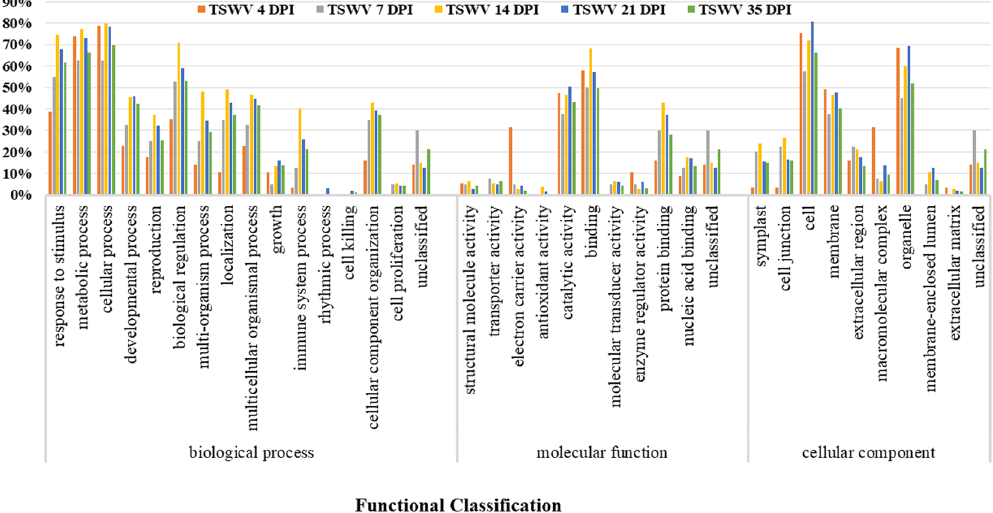
Figure 2. Gene Ontology (GO) functional classification of differentially expressed genes (DEGs). The percentage of genes assigned to each category were calculated at 4, 7, 14, 21 and 35 dpi,